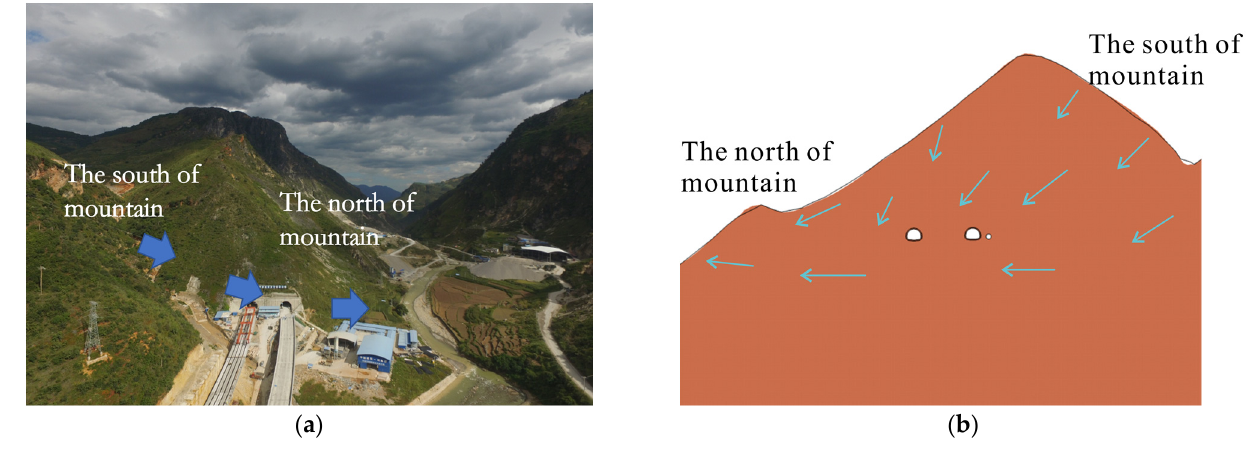
Figure 10. Schematic diagram of water inrush mechanism: ( a ) the actual terrain; ( b ) 2D model sec-